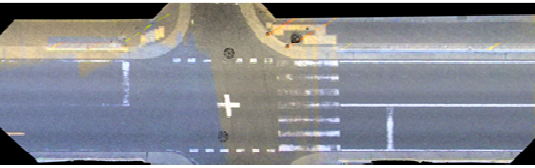
Figure 14. Color distribution chart